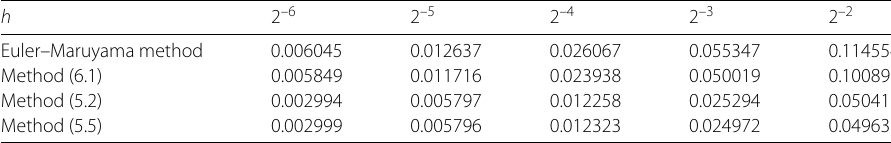
Table 1 The endpoint sample average errors with different methods for solving (6.3) h 2 –6 2